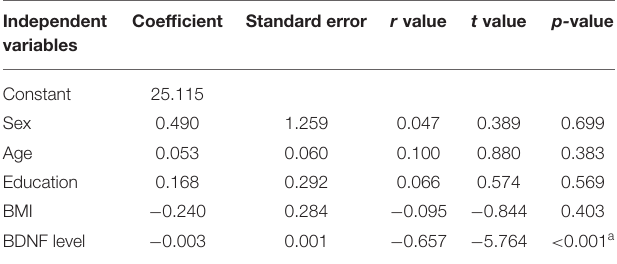
TABLE 3 | Multivariate regression models for RLS severity assessed by IRLSSG-RS scores in PD patients with RLS.